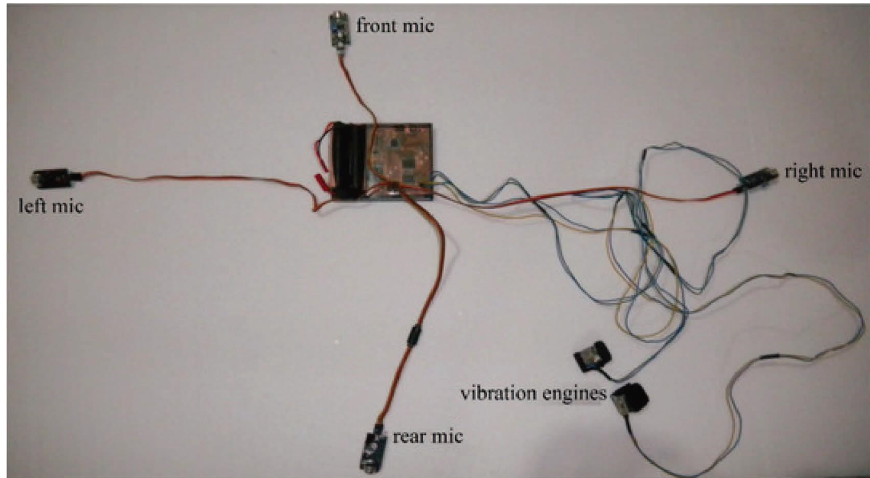
Figure 6: Te developed wearable system